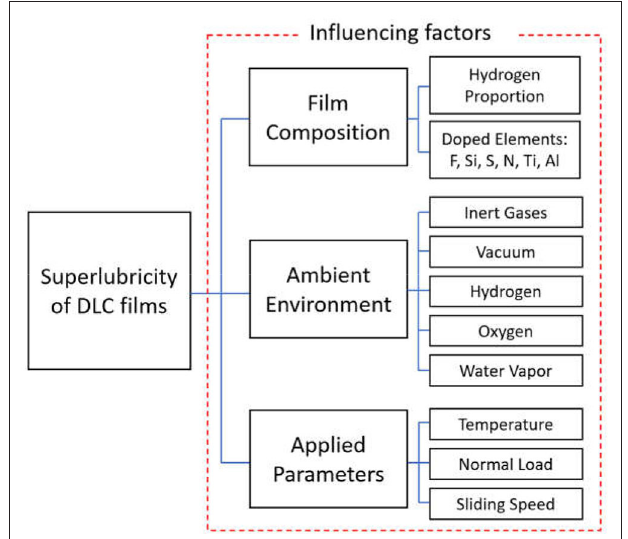
FIGURE 2 | Major influencing factors of superlubricity achieved with DLC